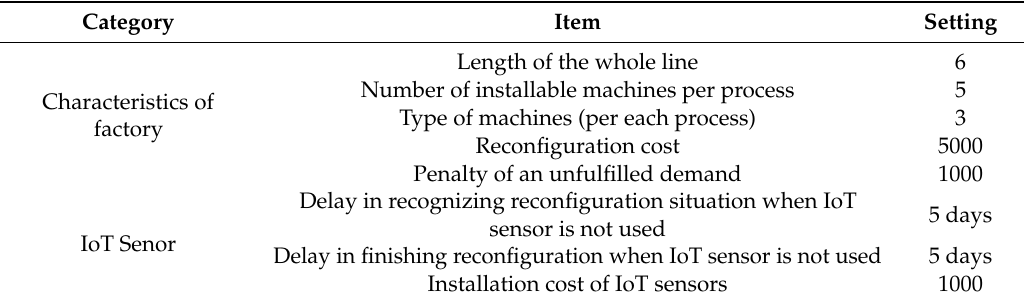
Table 4. Setting of simulation factory.